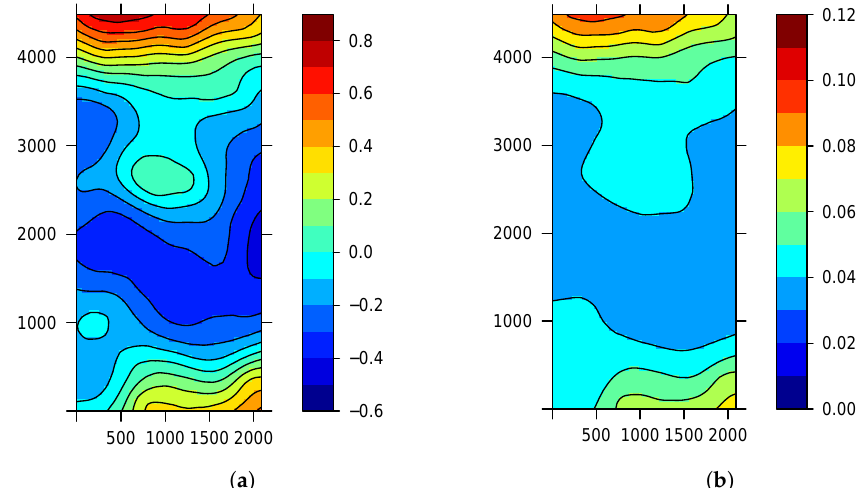
Figure 5. Posterior mean of the spatial effect ( a ) and of π i | Y ( b ) for random samples of 25%.